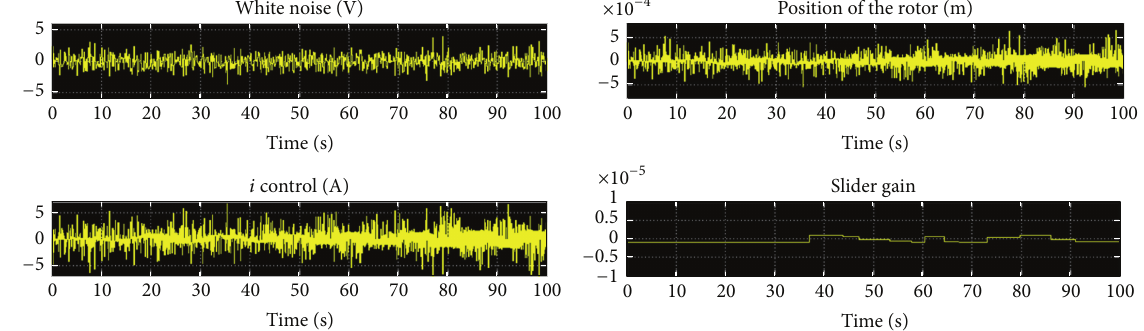
Figure 17: System response to enforced changes of the 𝑥 position. System with PID controller with proportional gain of 319.0187, integral gain of 1273.2977, and differential gain of 7.2565 and white noise of 0.001 volts.